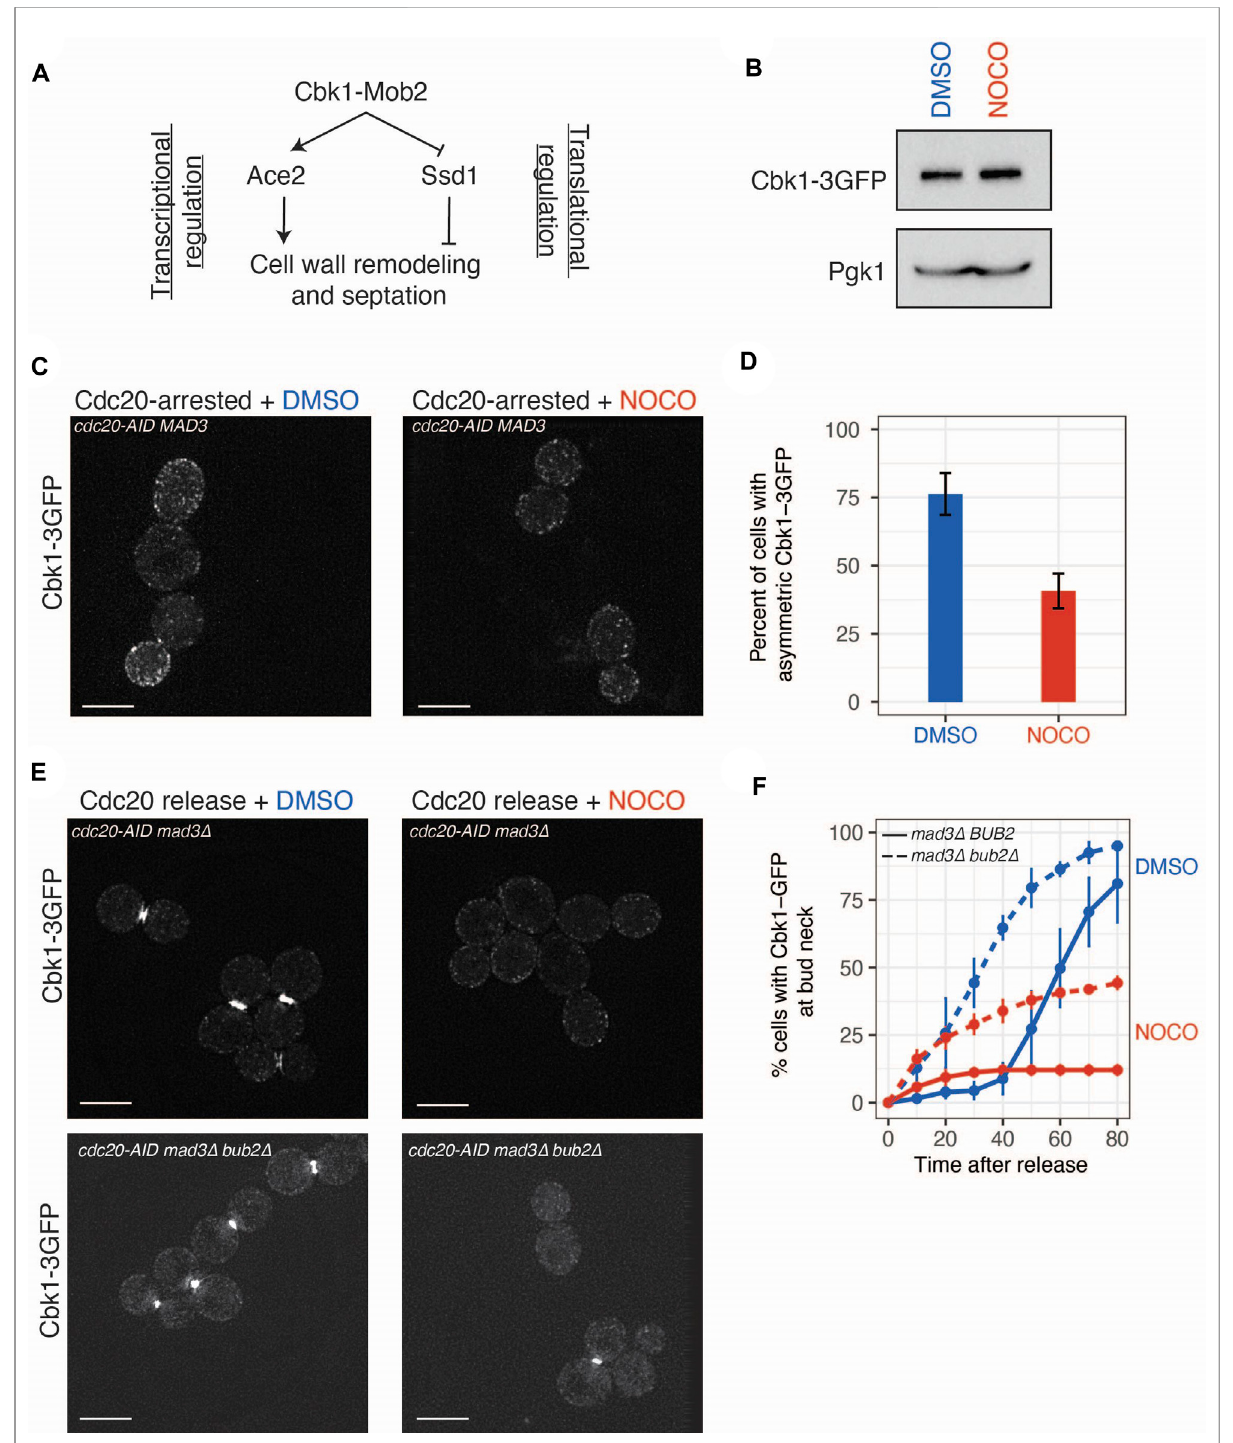
FIGURE 3 Cbk1 localization is altered in nocodazole treated cells. (A) Model of Cbk1 signaling pathway controlling transcription and translation of genes involved in cell wall remodeling. (B) Immunoblot with anti-GFP antibodies from whole cell extracts of CDC20-AID arrested cells (SBY20970) treated withDMSO ornocodazole for2.5 htoanalyze Cbk1-GFPlevels.Pgk1 isaloadingcontrol. (C) Nocodazolediminishesaccumulation ofCbk1-3GFPin daughter cells. CDC20-AID cells (SBY20970) were arrested in mitosis and treated with DMSO or nocodazole (10 μ g/ml) for 2.5 h and live imaged on agarose pads. Scale bar, 5 μ m. Two representative images. (D) Binning of Cbk1-3GFP localization phenotype. N = 3 independent replicates,errorbarsrepresentstandarddeviation. p -valuederivedfromtwo-tailedStudent ’ s t -test. (E)